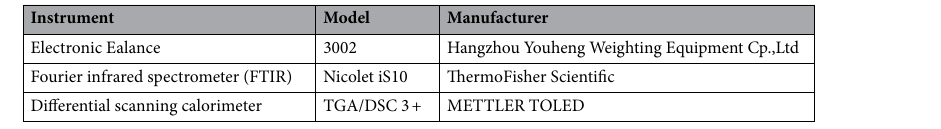
Table 2. List of experimental